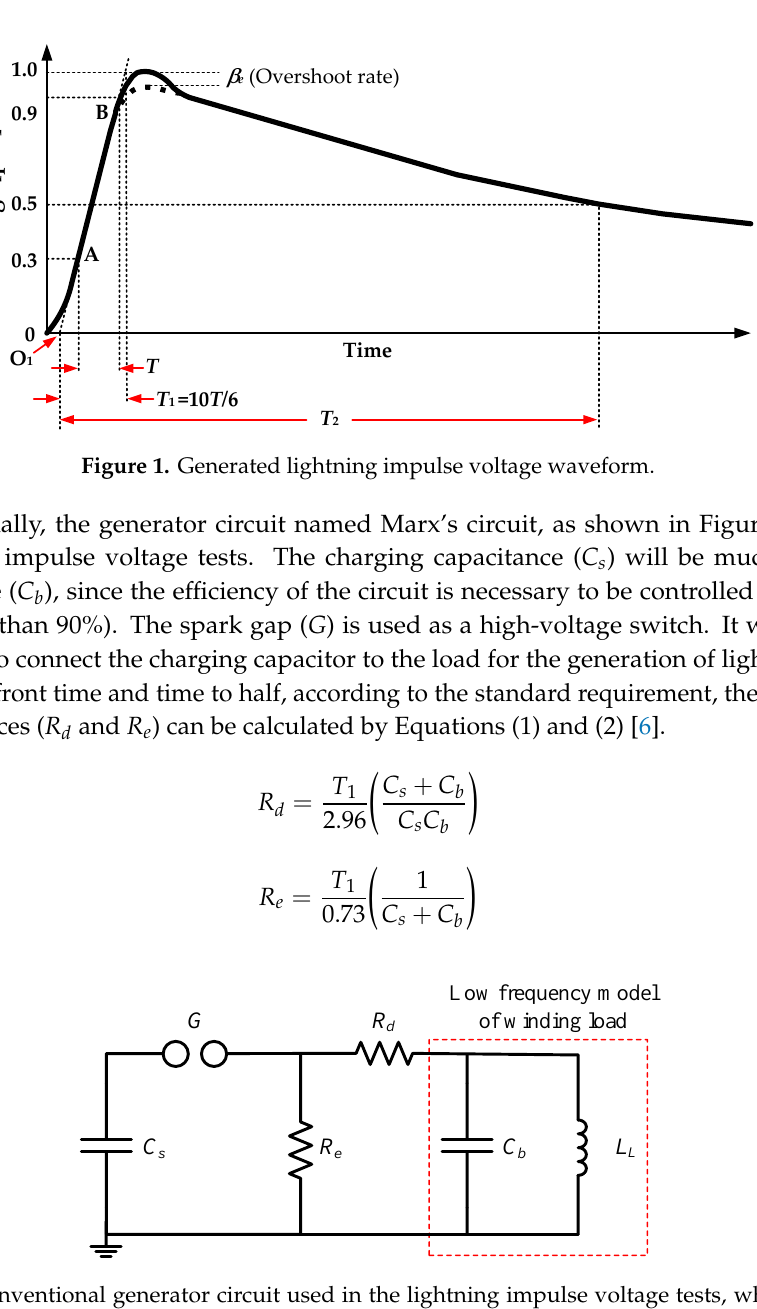
Figure 1. Generated lightning impulse voltage waveform.